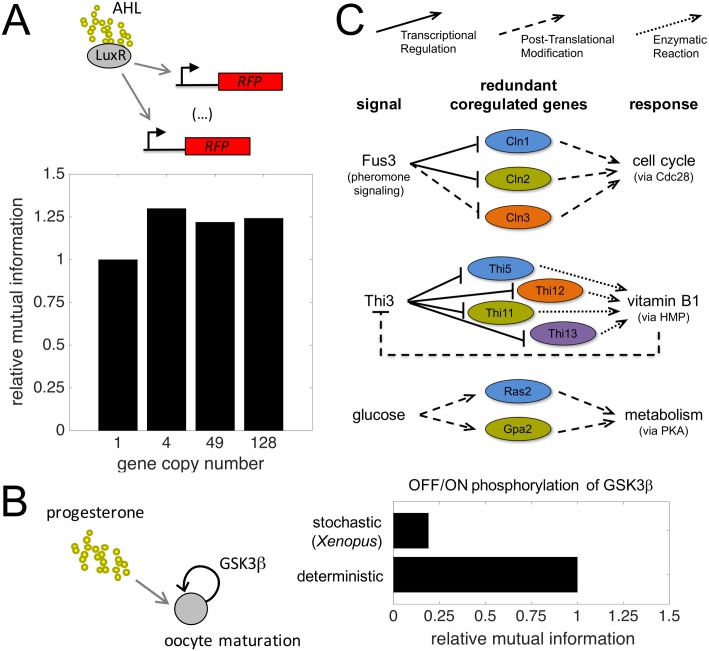
Experimental evidence of the role of genetic redundancies for the transmission of information.(A) (Top) Regulatory scheme of a synthetic experimental system taken to assess the effect of genetic redundancy on information transfer. An array of N RFPs regulated by LuxR-AHL, implemented through chromosomal integration (N = 1) or plasmids with different copy numbers (N > 1). (Bottom) Dependence of mutual information (MI) with the number of units (N) relative to the system with N = 1 (Materials and Methods). (B) (Left) Regulatory scheme associated to the induction of oocyte maturation in a bistable manner (mediated by GSK3β) by progesterone. (Right) Effect of molecular noise on information transfer. MI for this intrinsically stochastic threshold unit relative to the deterministic case (Materials and Methods). (C) Three examples of genetic regulatory architectures in yeast where redundant genes are coregulated by a common signal. They correspond to pheromone, vitamin B1 and glucose signaling, respectively.